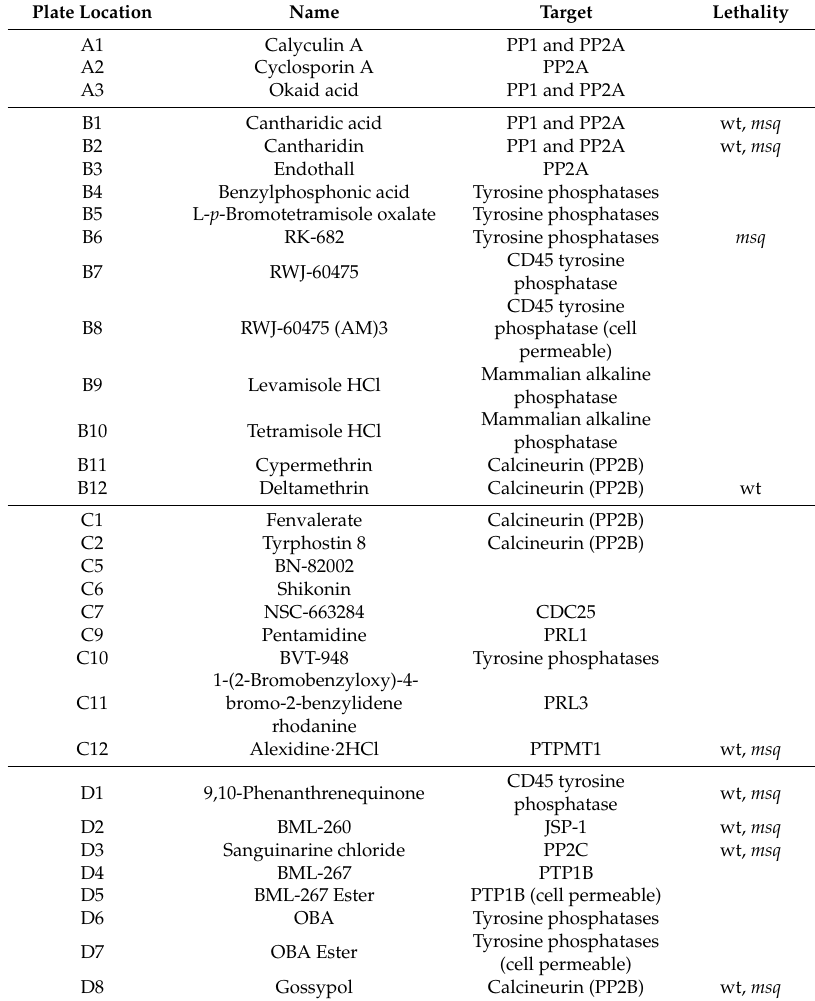
Table A1. Modified ENZO ® library of protein phosphatases